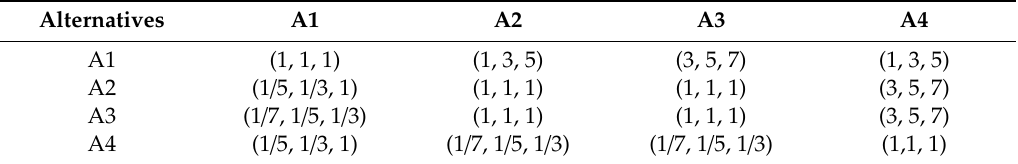
Table 11. Evaluation with respect to risk.